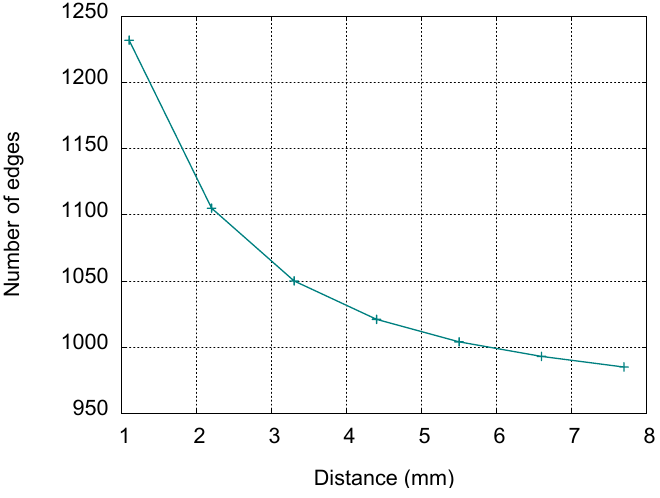
Figure 13. Measured number of edges with a large conductive target.